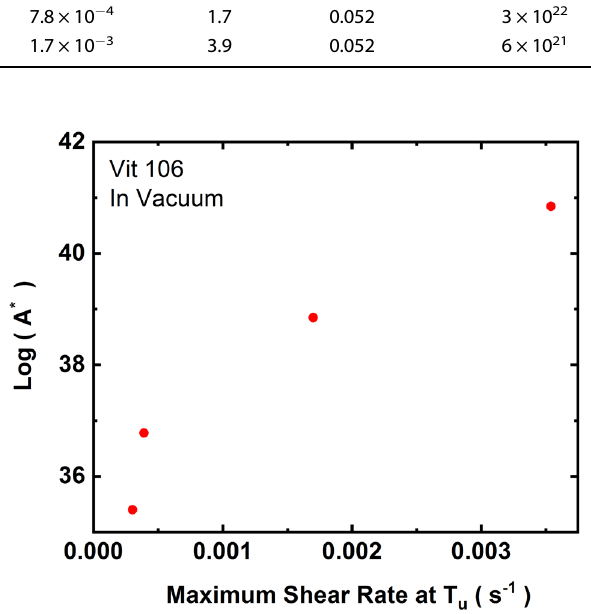
Fig. 2 The prefactor A * for nucleation as a function of the maximum shear rate at the nucleation temperature ( T u ) for processing in vacuum for liquid Vit106 (Zr 57 Cu 15.4 Ni 12.6 Al 10 Nb 5 ). The nucleation temperatures and the relevant parameters